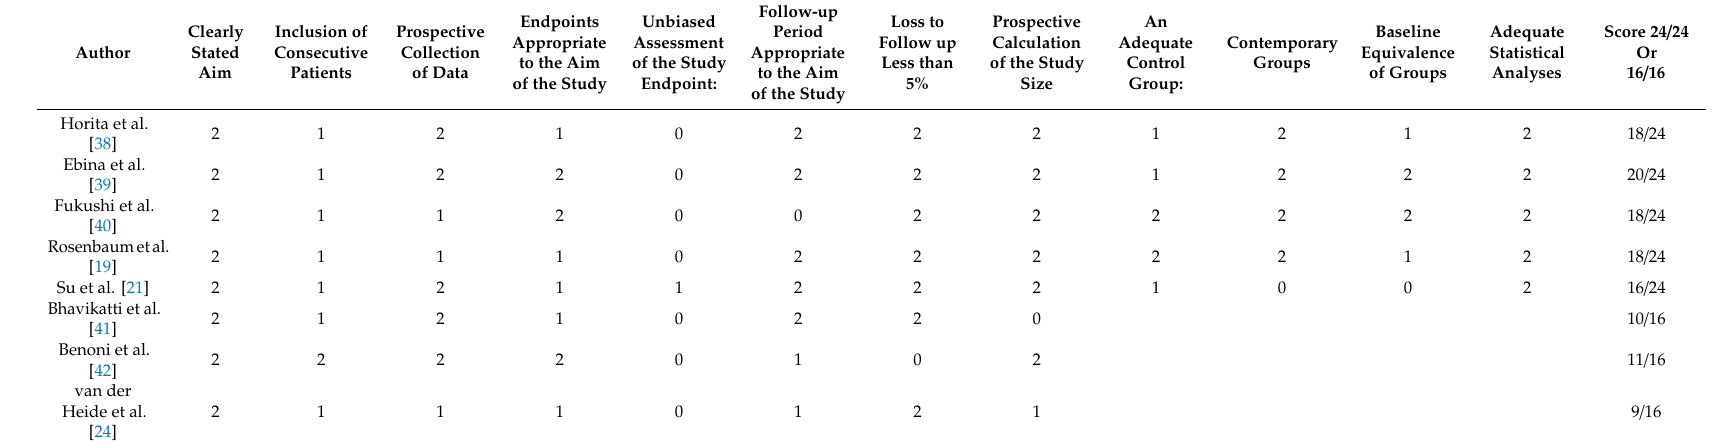
Table 4. Quality assessment of the NRCTs studies considered, according to the MINORS